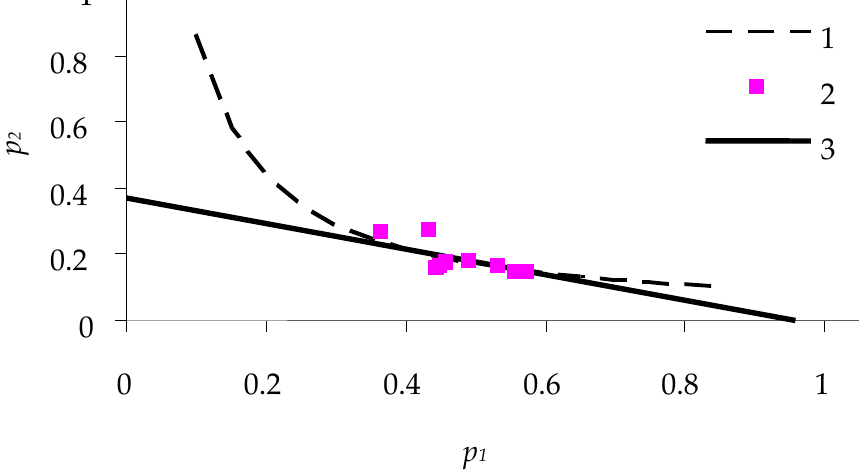
7 of 14 Figure 3. The energy balance of spongy moth females on birch: (1) characteristics ( p 1 , p 2 ) of individ- ual caterpillars; (2) efficiency curve q = p 1  p 2 ; (3) line of budgetary constraints on feed consumption. From the characteristics of nutritional balance, the following parameters of consump- tion efficiency of birch leaves by spongy moth caterpillars were calculated: